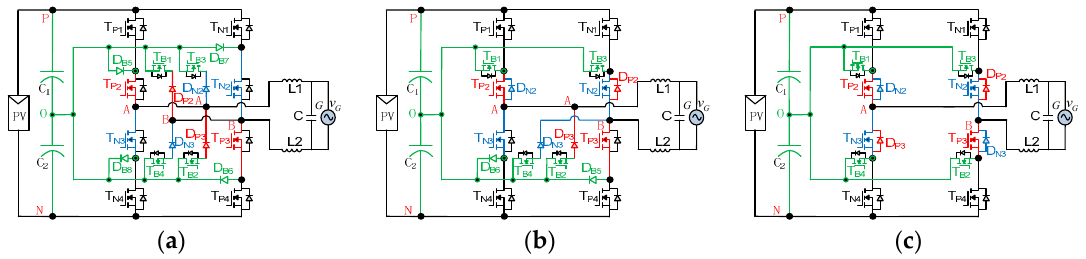
Figure 20. Direct Connection NPC topologies from M = 4, N = 4. ( a ) R11S2 (new); ( b ) R12S2 (new); ( c ) R13S2 (new).